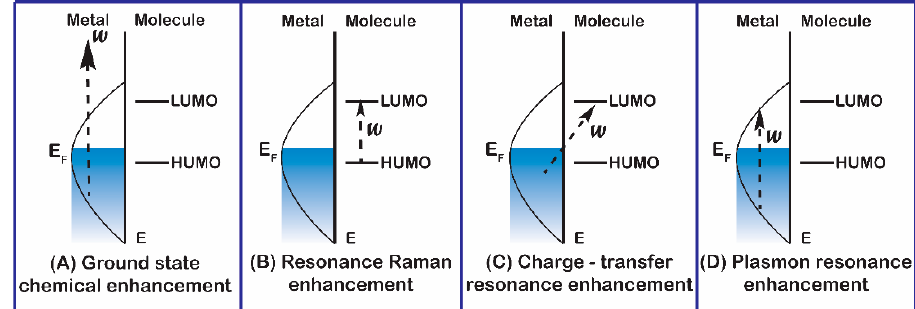
Figure 5. Schematic depiction of chemical enhancement mechanisms applied in SERS [35].